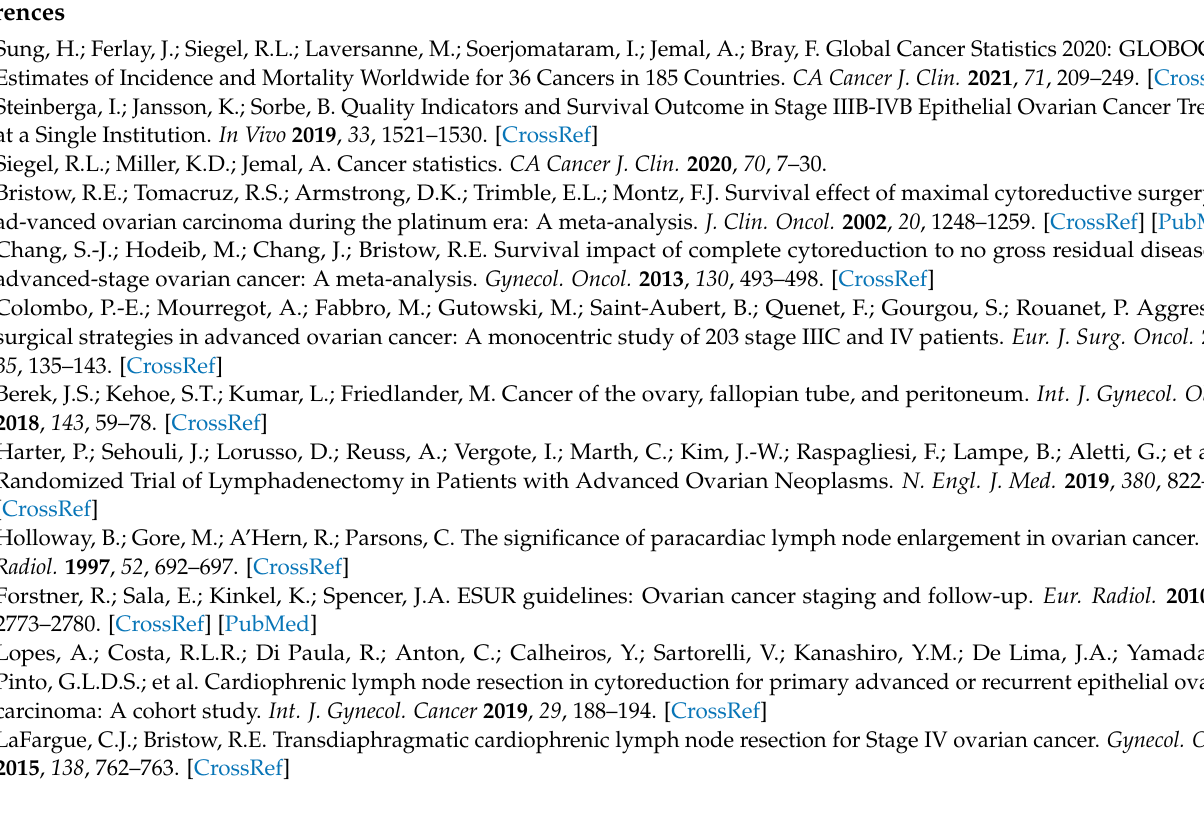
abdominal cytoreductive surgery, Figure S4: Funnel plot, using data from 5 studies of 5-year disease free survival in advanced stage EOC with CPLN